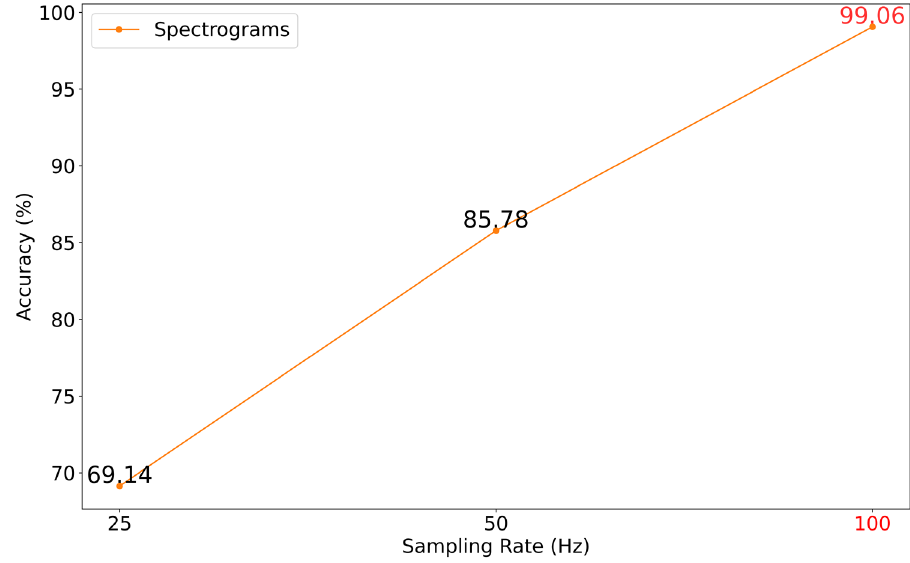
Figure 8. ECG sampling rate influence (down sampling) on algorithm quality: x -axis (sampling rate), y -axis (accuracy).